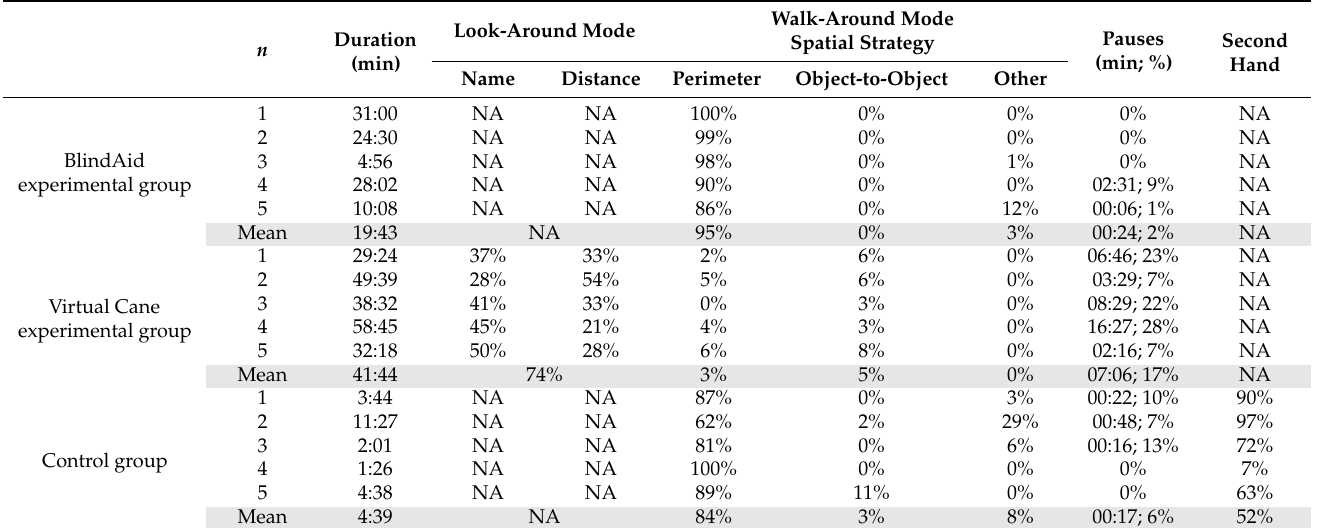
Table 2. Exploration process in simple